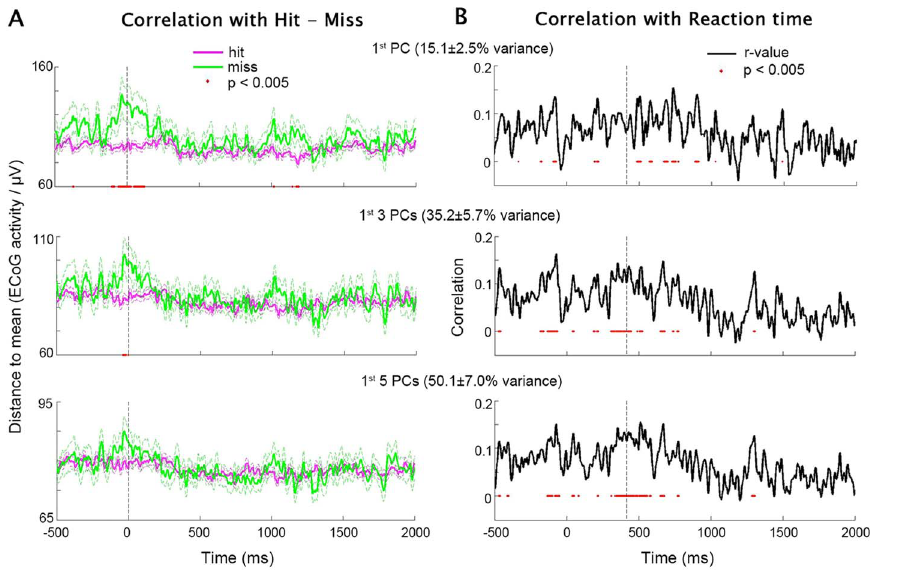
Figure 4. PCA test of the Inverted-U hypothesis using contralateral data. ( A ) D(t) combined across the first one (top), three (middle) and five (bottom) PCs in each subject, averaged for hit and miss trials separately (data from all subjects were included). Flanking dashed lines depict mean 6 SEM. Red dots: P , 0.005 for hit vs. miss trials, two-sample t-test. Vertical dashed line indicates stimulus onset. ( B ) Time courses of Pearson correlation coefficient between D(t) and RT across all hit trials (including data from all subjects). D(t) was combined across the first one (top), three (middle) and five (bottom) PCs in each subject. Red dots: P , 0.005 for significant D(t) -RT correlation. Vertical dashed line indicates the time of median RT across all subjects.